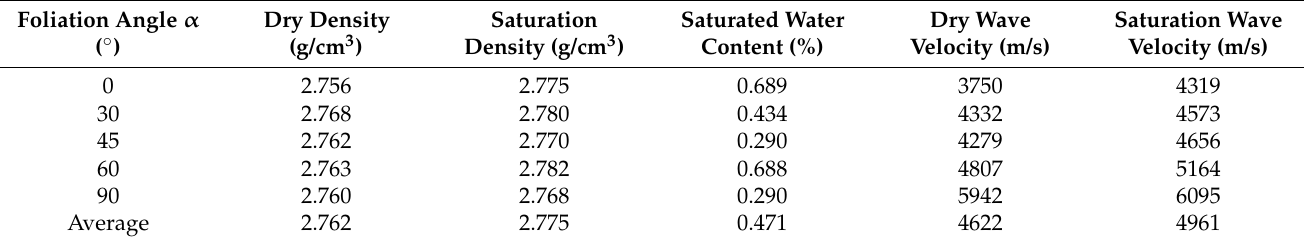
Table 1. Basic physical properties of phyllite with different foliation angles.